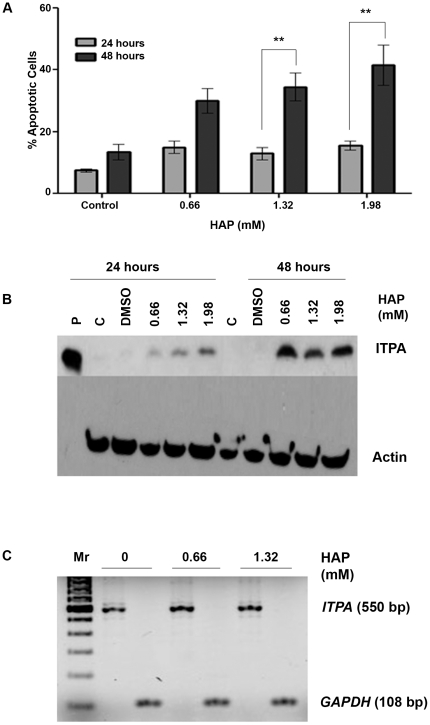
Effects of HAP treatment on apoptosis and ITPA levels in HeLa cells.(A) HAP treatment causes apoptosis in HeLa cells after treatment for 24 or 48 hours. By two-way ANOVA, ptime = 0.001 and pconcentration = 0.0046. **p<0.01 by Bonferroni multiple comparison post test for column analysis comparing means for 24 hours vs. 48 hours. (B) HAP treatment leads to the increase of ITPA protein levels in HeLa extracts following treatment for both 24 hours and 48 hours. Western blots were performed as described in Materials and Methods. P- pure ITPA protein, C- untreated control, DMSO – solvent only. (C) HAP treatment does not increase levels of ITPA transcripts. The analysis was performed as described in Materials and Methods. HAP treatment was for 24 hours. Mr – 100 bp ladder.